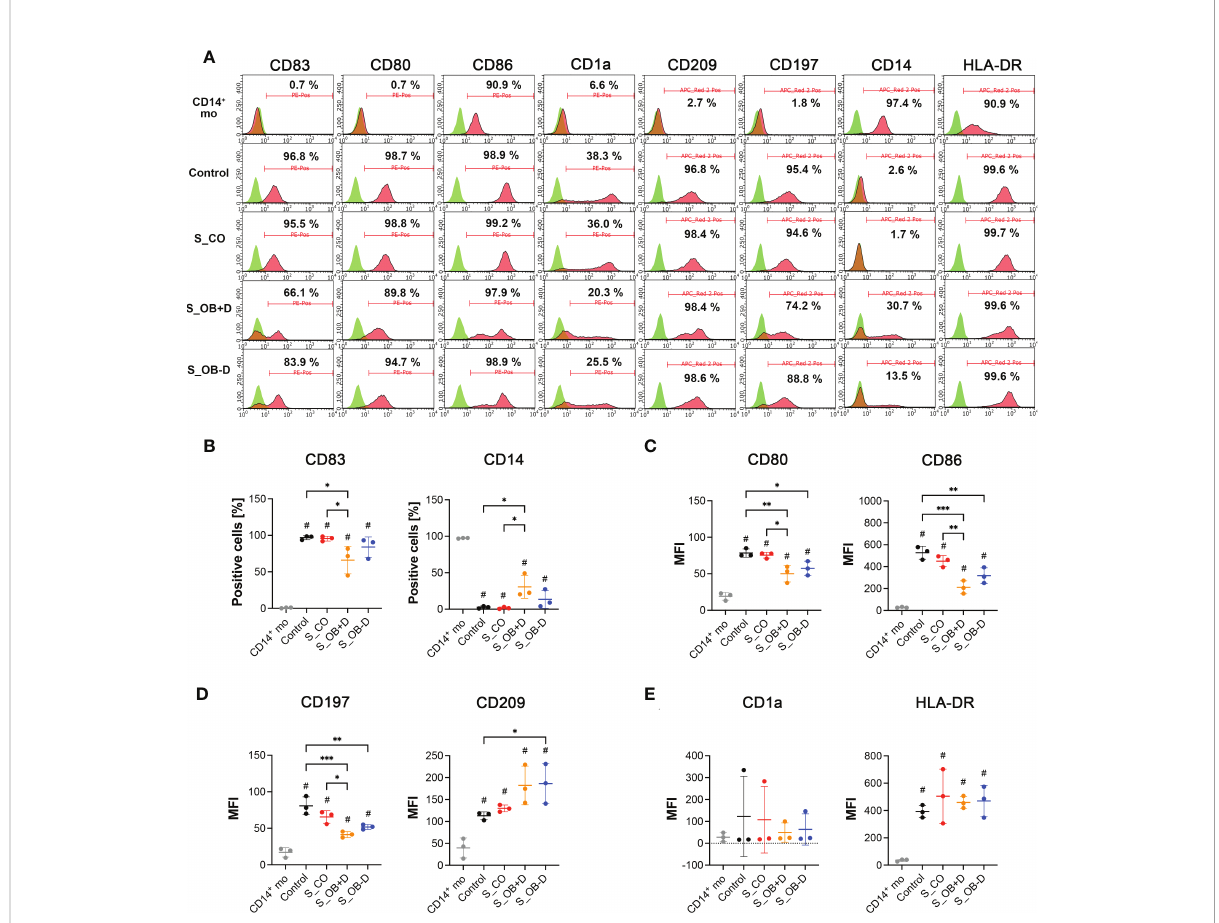
FIGURE 2 Cell surface marker expression of CD14 + monocytes and DCs generated by various treatments. (A) Flow cytometry analysis (FACS) of cell surface markers on CD14 + monocytes (CD14 + mo) and DCs generated without (control) or in the presence of JPC secretomes derived from untreated (S_CO), and osteogenically induced cells with or without dexamethasone (S_OB+D/S_OB-D. Representative results from three independent experiments are given. Mean frequencies calculated from three independent experiments are given in each histogram. (B) Percentages of CD83 and CD14 positive cells. (C – E) Median fl uorescence intensities (MFI) of CD80, CD86, CD197, CD209, CD1a and HLA-DR expression. Data of three independent experiments are given as means ± SD and compared using one-way ANOVA followed by Tukey ’ s multiple comparisons tests (n=3, *p < 0.05, **p < 0.01, ***p < 0.001; # p < 0.5 compared to CD14 +